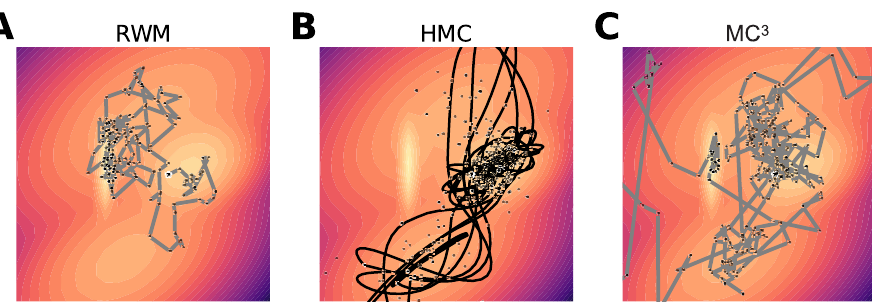
Fig 2. Example trajectories for the three samplers for a mixture of multivariate Gaussians. (A) Random Walk Metropolis (RWM), (B) Hamiltonian Monte Carlo (HMC), and (C) Metropolis-coupled MCMC (MC 3 ).